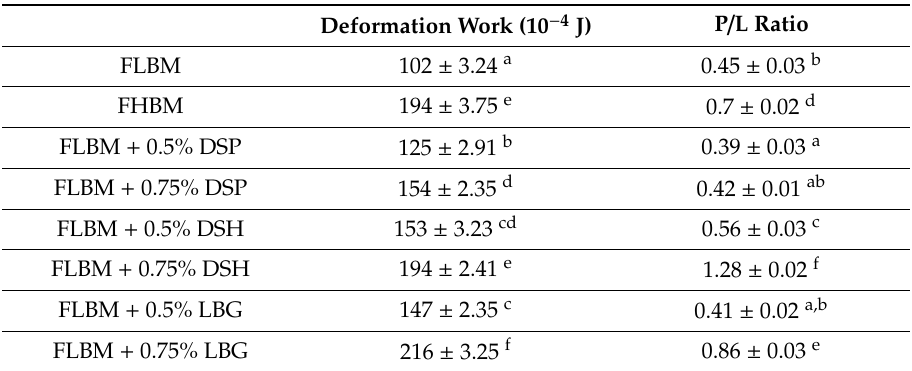
Table 3. The alveograph characteristics of dough containing di ff erent levels of DSP and DSH extracted from the Allig